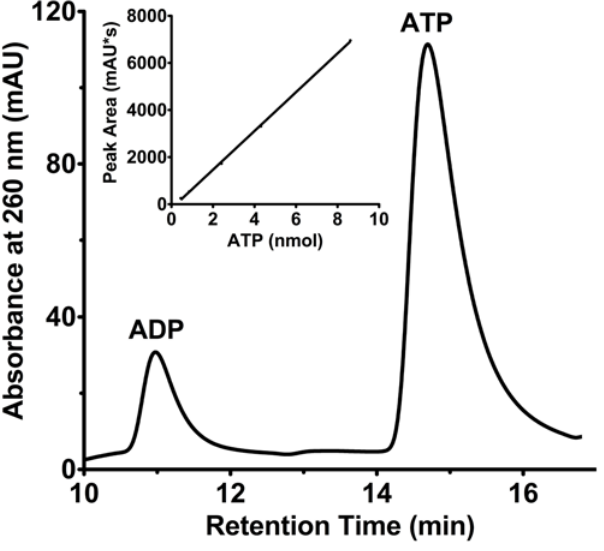
Figure 5. M.tuberculosis Rv2623 is a nucleotide-binding USP. High Performance Liquid Chromatography (HPLC) analysis of endoge- nously bound nucleotides from purified His 6 -Rv2623. Nucleotides species were identified based on their specific retention times on the Mono Q HR 5/5 column, represented by peaks in absorbance at 260 nm, which correspond to that of nucleotide standards (not shown). Bound nucleotides were extracted by boiling, and separated and quantified from a standard curve that relates absorbance peak area to the known amount of ATP injected onto the column (inset).